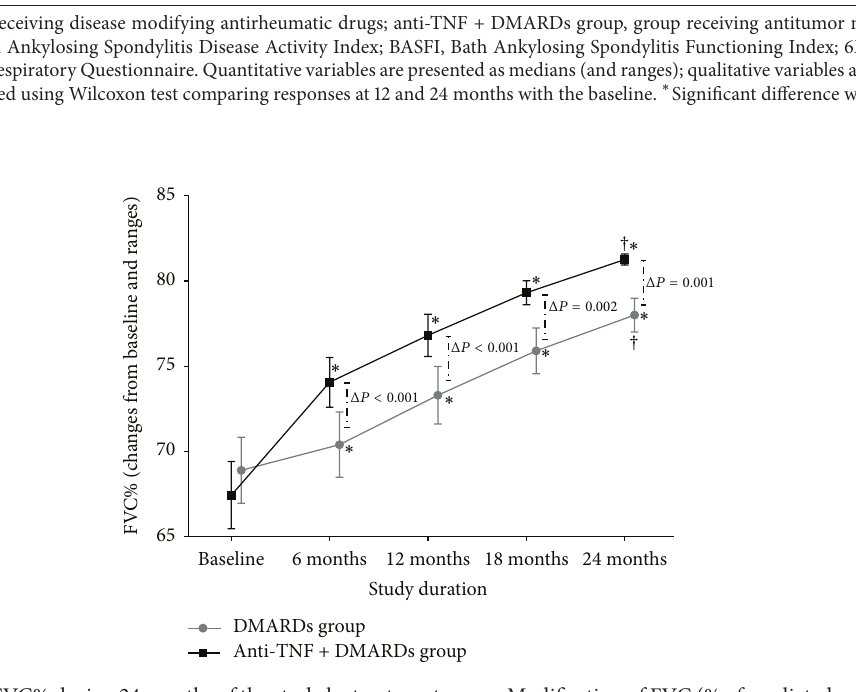
Figure 2: Changes in FVC% during 24 months of the study by treatment group. Modification of FVC (% of predicted value) from baseline to 2 years in the DMARDs ( 𝑛 = 20 ) and anti-TNF + DMARDS group ( 𝑛 = 16 ). Gray circle is DMARDs group, and black square is anti-TNF + DMARDs group. Values are represented as mean and standard error of the mean. ∗ Comparison in means of each evaluation versus baseline using paired Student 𝑡 -test ( 𝑃 < 0.001 ). Δ Comparison of the absolute change at 6, 12, 18, and 24 months between groups using unpaired Student 𝑡 -test. † Two-factor ANOVA Friedman test 𝑃 < 0.001